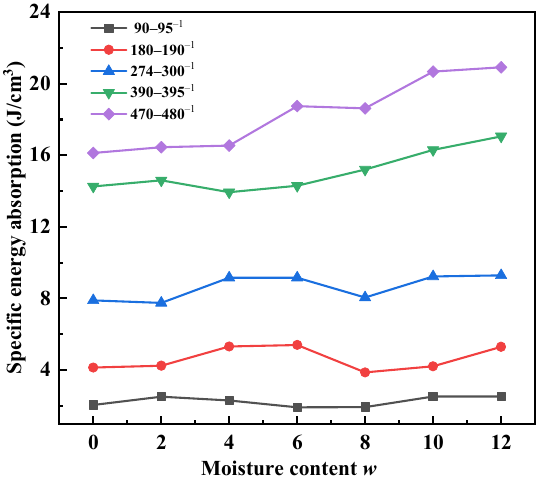
Figure 22. Variations in specific energy absorption with moisture content at different strain rates.